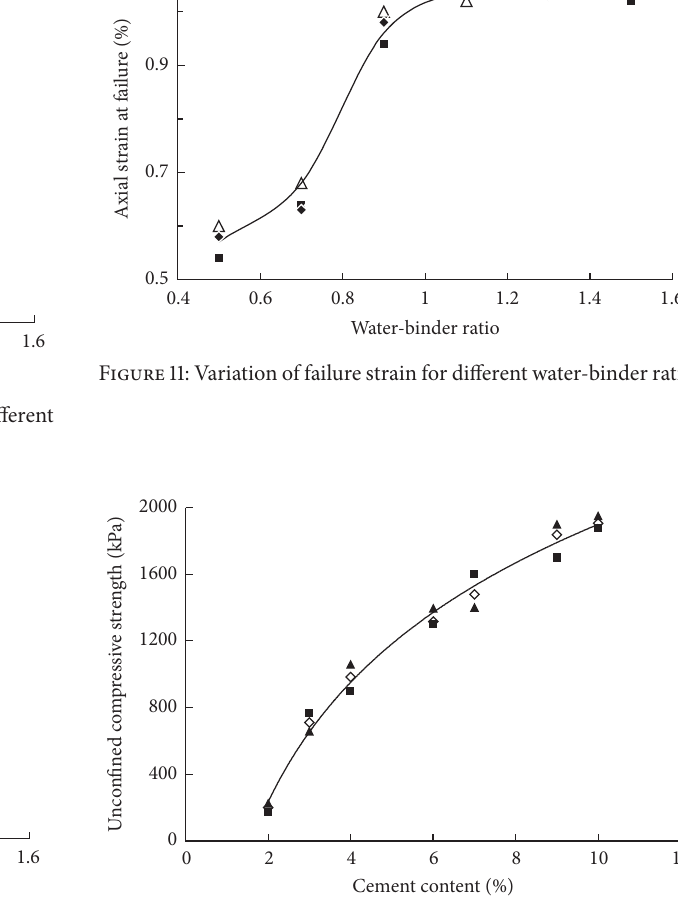
Figure 12: Variation of unconfined compressive strength for differ- ent cement